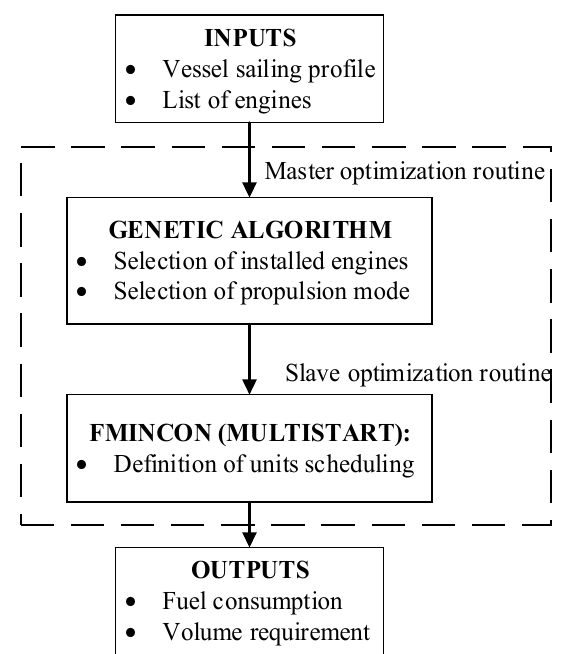
Figure 5. Mixed integer non-linear programming (MINLP) optimization routine.